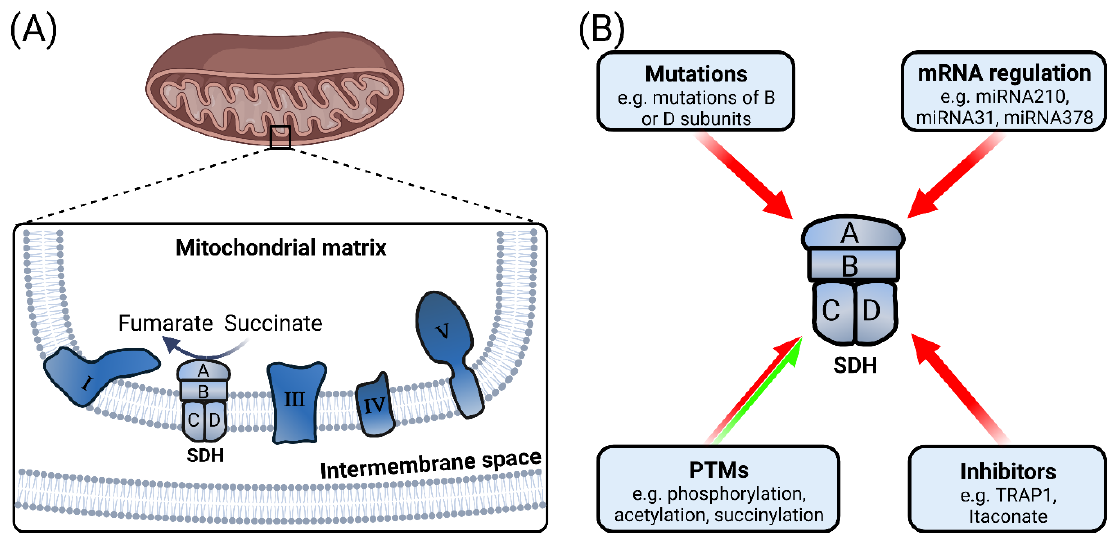
Figure 3. SDH is a key enzyme metabolizing succinate in the mitochondria. ( A ) SDH complex is composed of 4 subunits and is part of the electron transport chain in the inner mitochondrial membrane. ( B ) SDH expression and/or activity can be regulated by different effectors. Red arrows indicate that these regulators reduce SDH expression and/or activity, while the split red and green arrow indicates possible upregulation or downregulation of SDH activity. PTMs: post-translational modifications, TRAP1: tumor-necrosis-factor-receptor-associated protein 1.